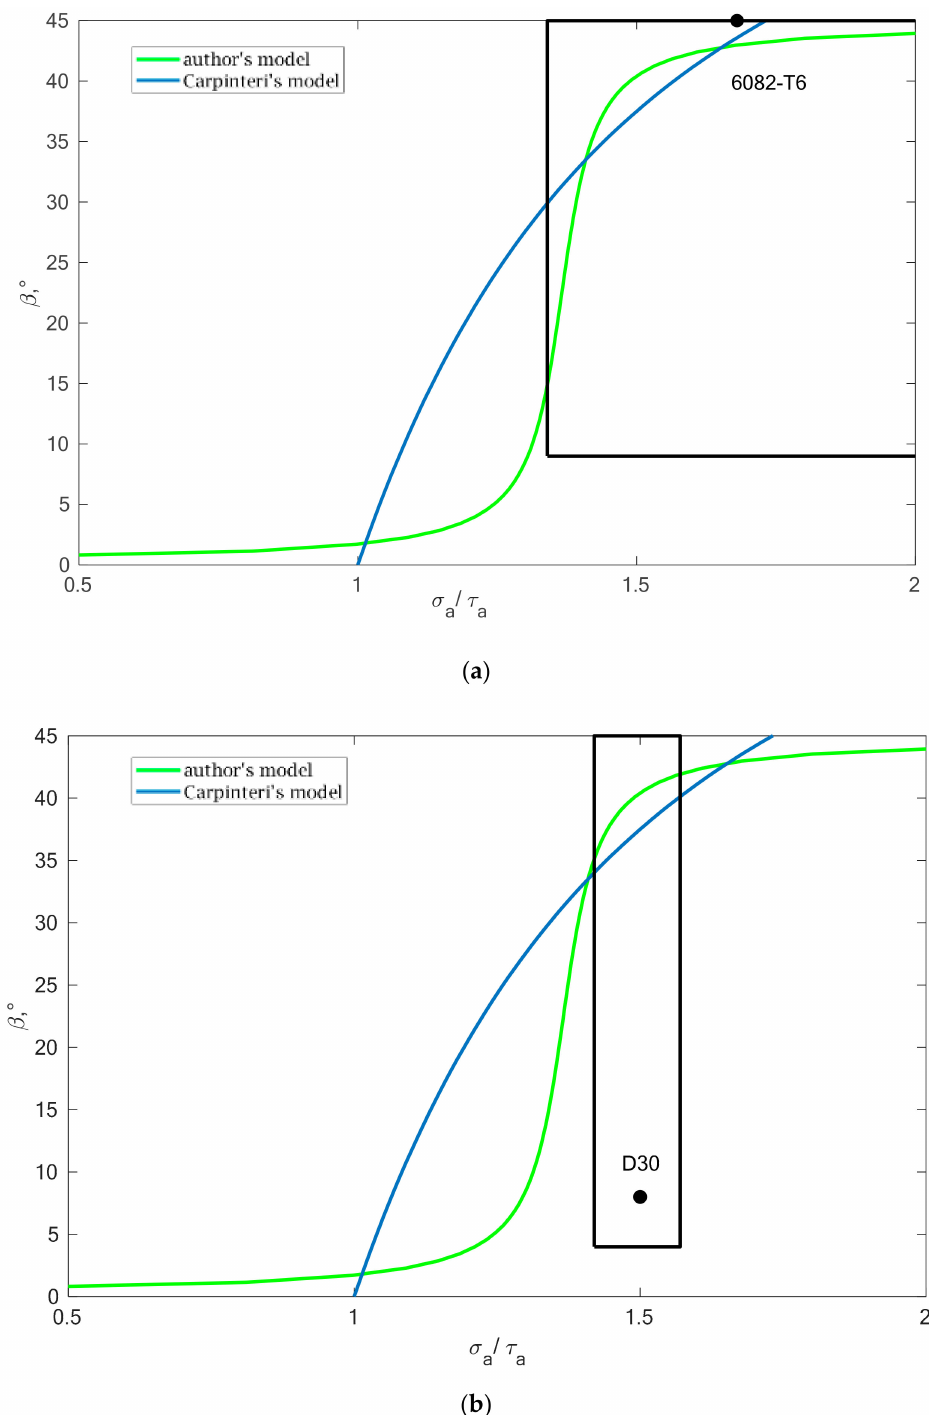
Figure 16. Secure area determined for ( a ) 6082-T6 and ( b ) D30 aluminium alloys in terms of the β angle in relation to the ratio of normal stresses to shear